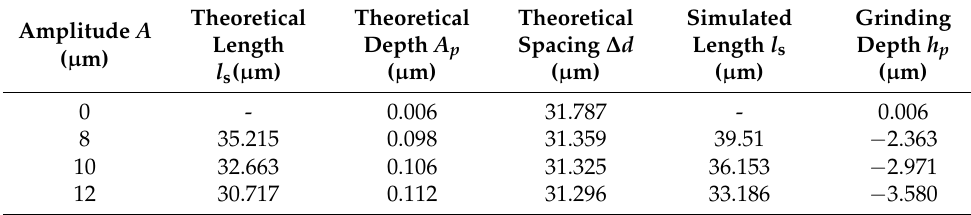
Table 4. Micro-pit dimension comparison of Group 1.